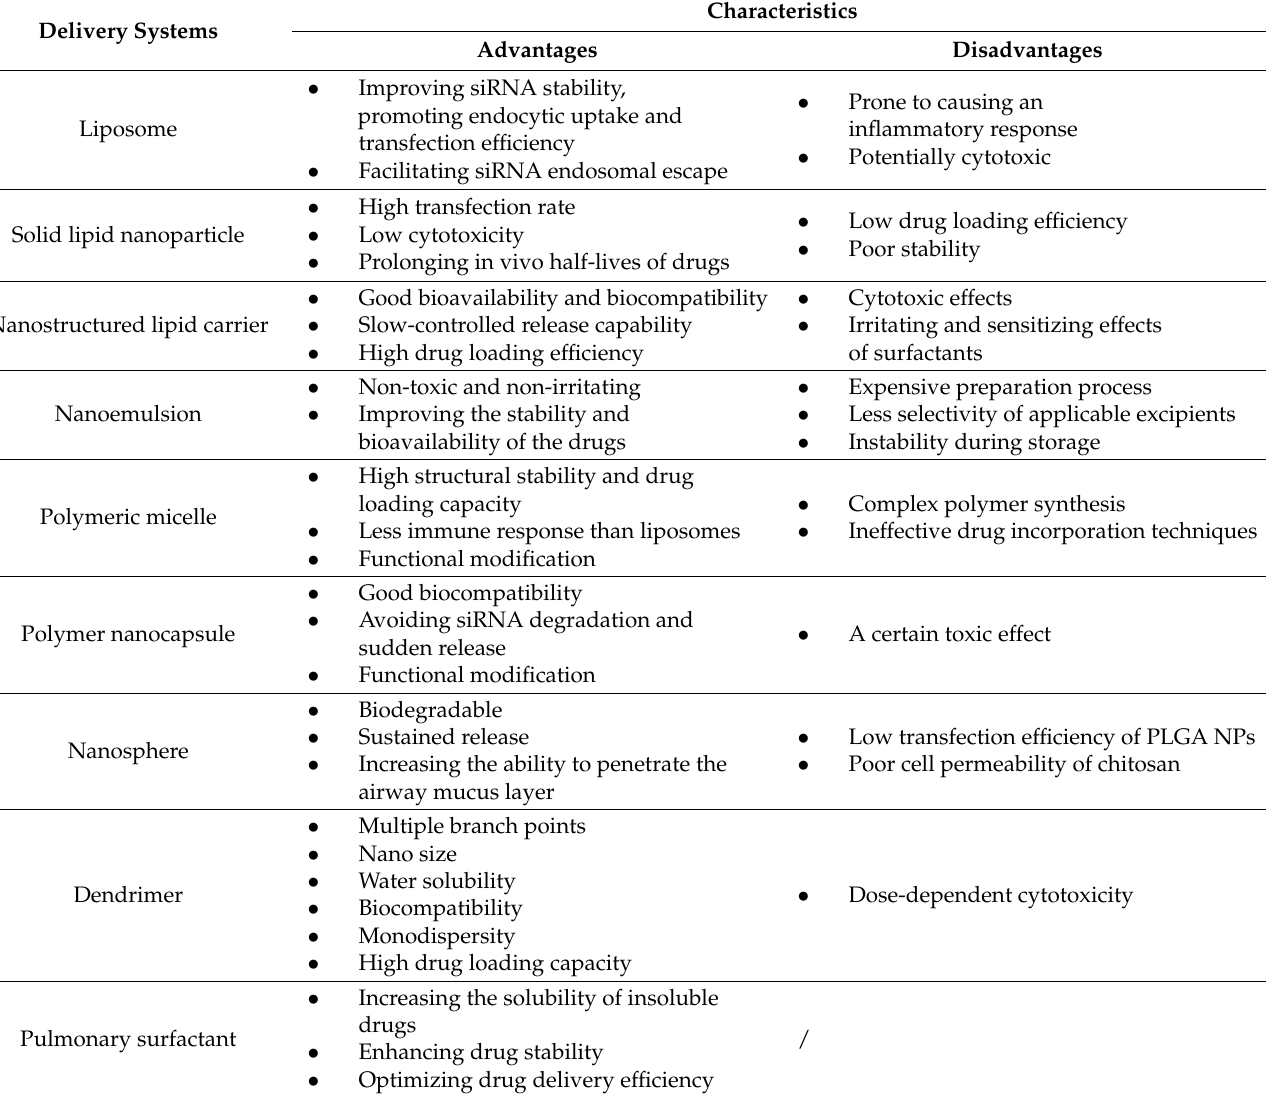
Table 4. The characteristics of the siRNA inhalation delivery